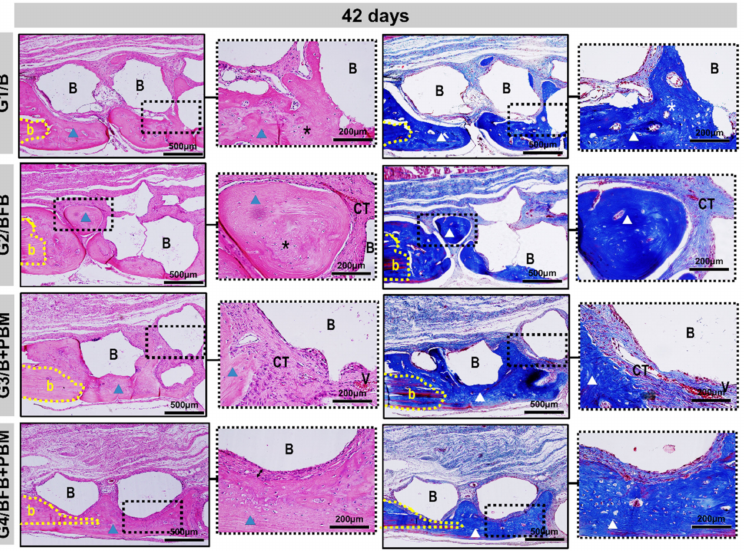
Figure 8. Details of the evolution of the bone repair process of the cranial defects at 42 days filled with biomaterial (G1/B), biocomplex consisting of biomaterial plus heterologous fibrin biopolymer (G2/BFB), biomaterial and PBM (G3/B + PBM), and biocomplex consisting of biomaterial plus het- erologous fibrin biopolymer and photobiomodulation with low-level laser therapy (G4/BFB + PBM). Mature lamellar tissue (triangle) was restricted to the edge of the defect (b) and areas of immature bone trabeculae (asterisk) in the fibrous connective tissue (CT). Biomaterial particles (B) surrounded by thicker collagen fibers, with a fibrous interface between the particles and newly formed bone (arrow). HE and Masson Trichrome; original magnification × 10; bar = 500 µ m and insert, images magnified × 40; bar = 100 µ